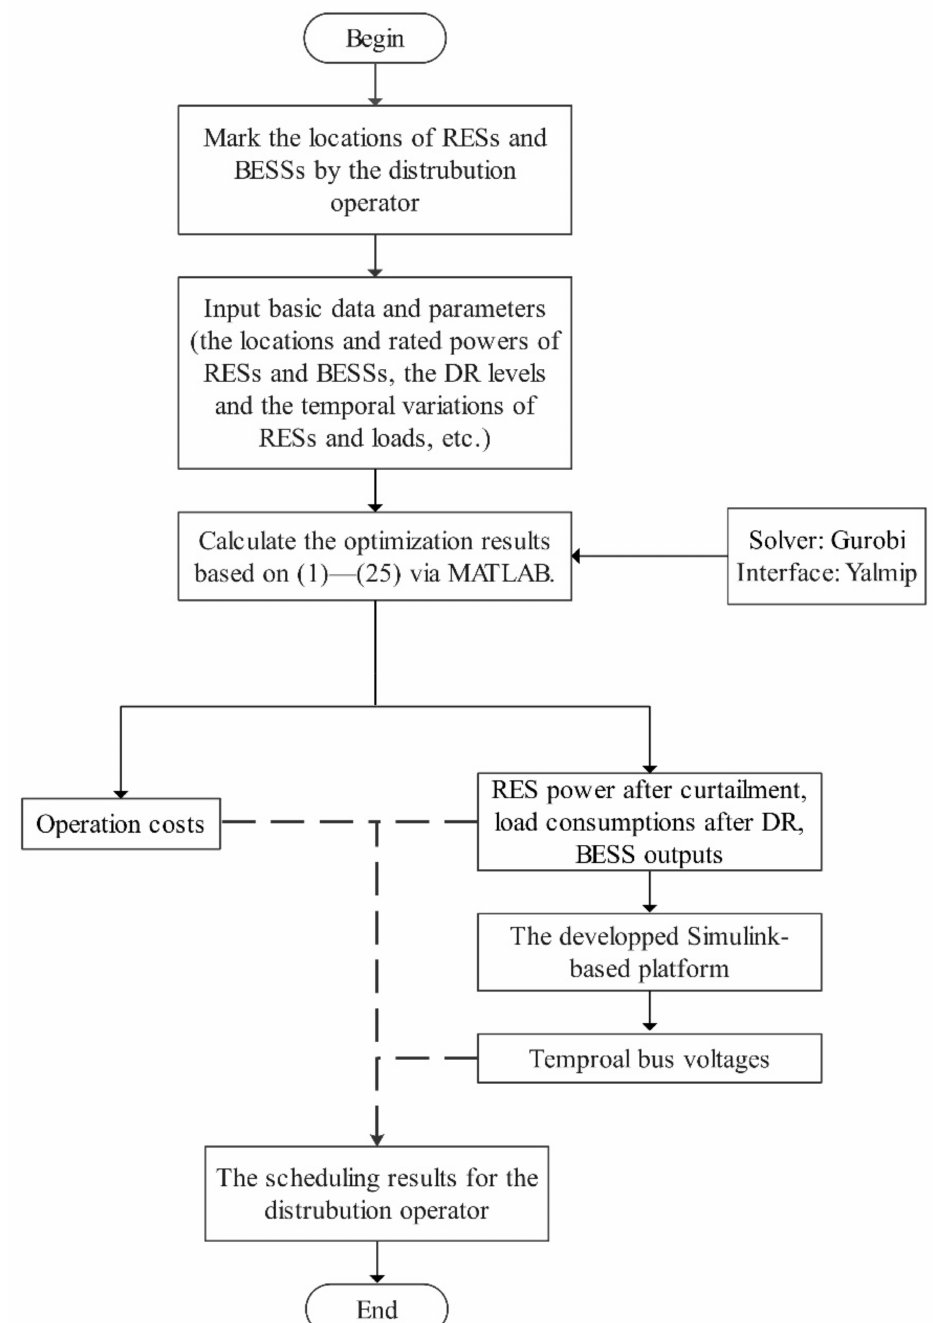
Figure 4. The flow chart of the utilization of the optimization model and simulation